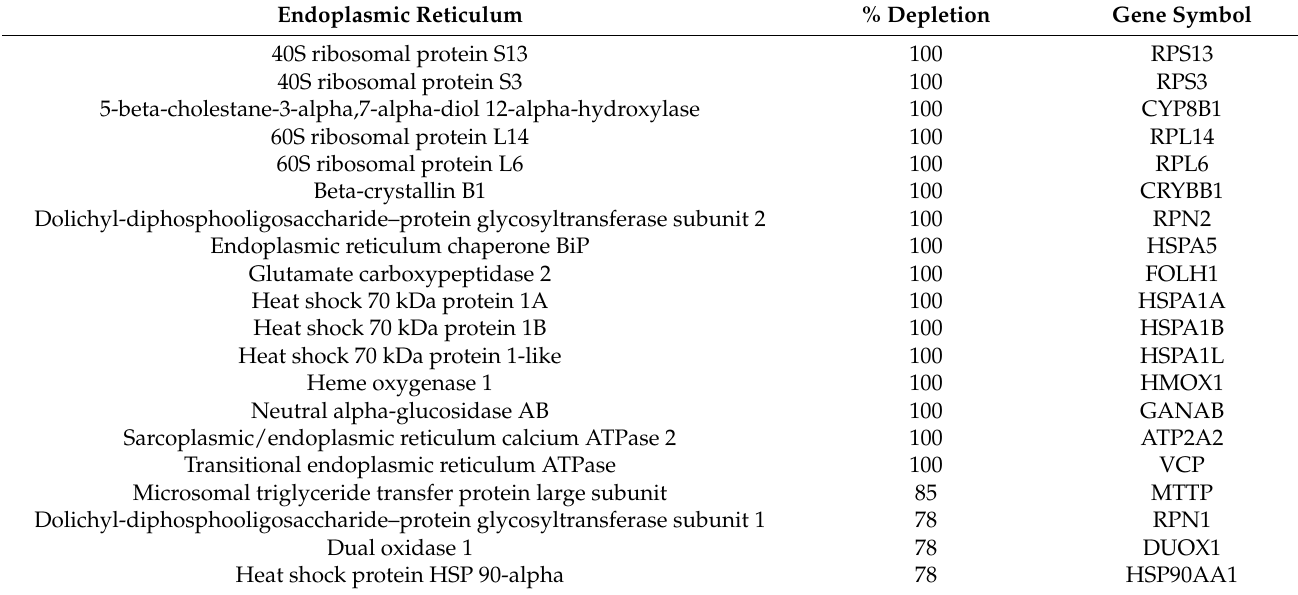
Table A1. Endoplasmic reticulum proteins depleted during decellularization.